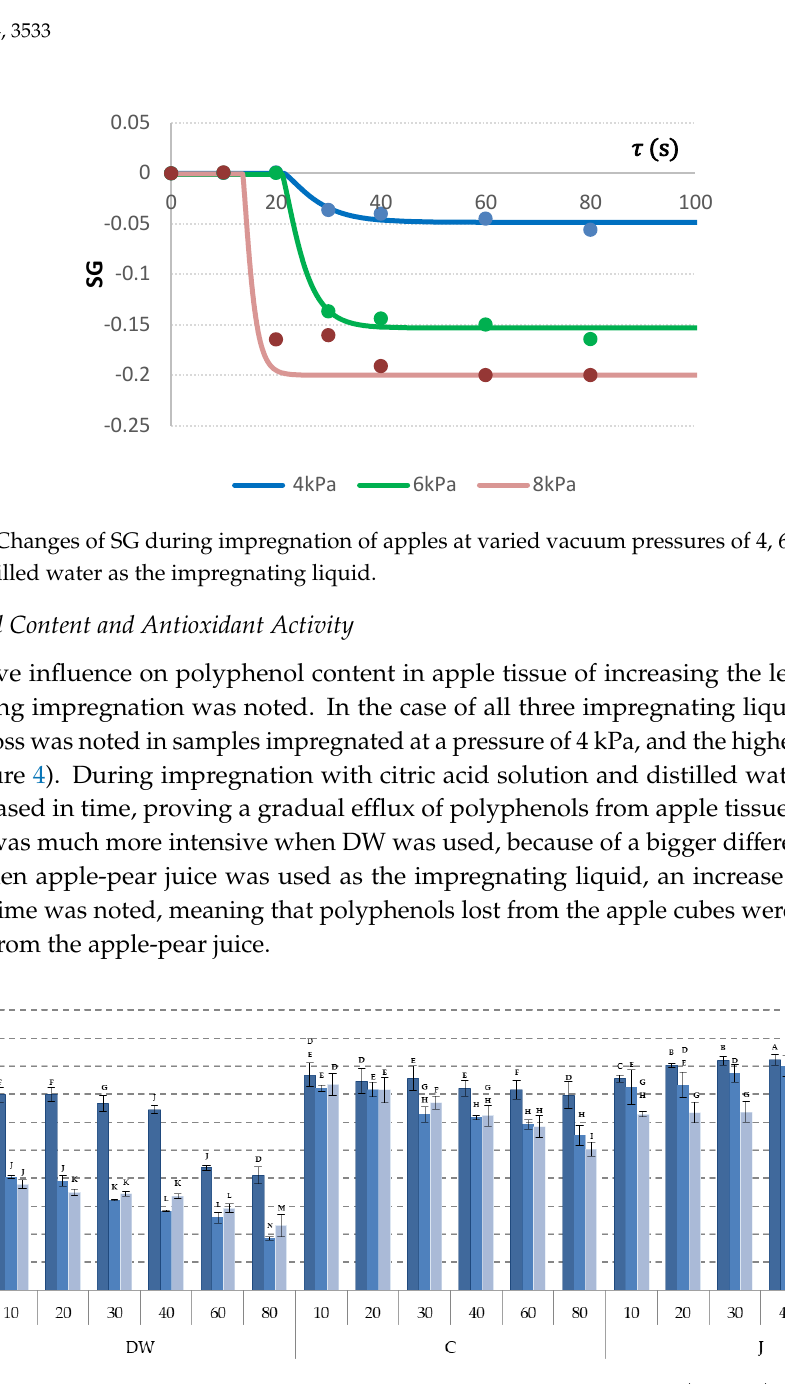
pressure level and impregnation time. The highest antioxidant activity was measured for samples 6). 6).